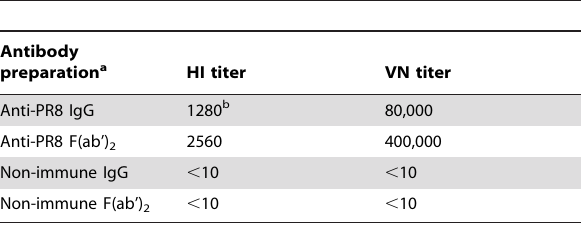
Table 1. Hemagglutination inhibition and virus neutralization titers of Ab preparations.